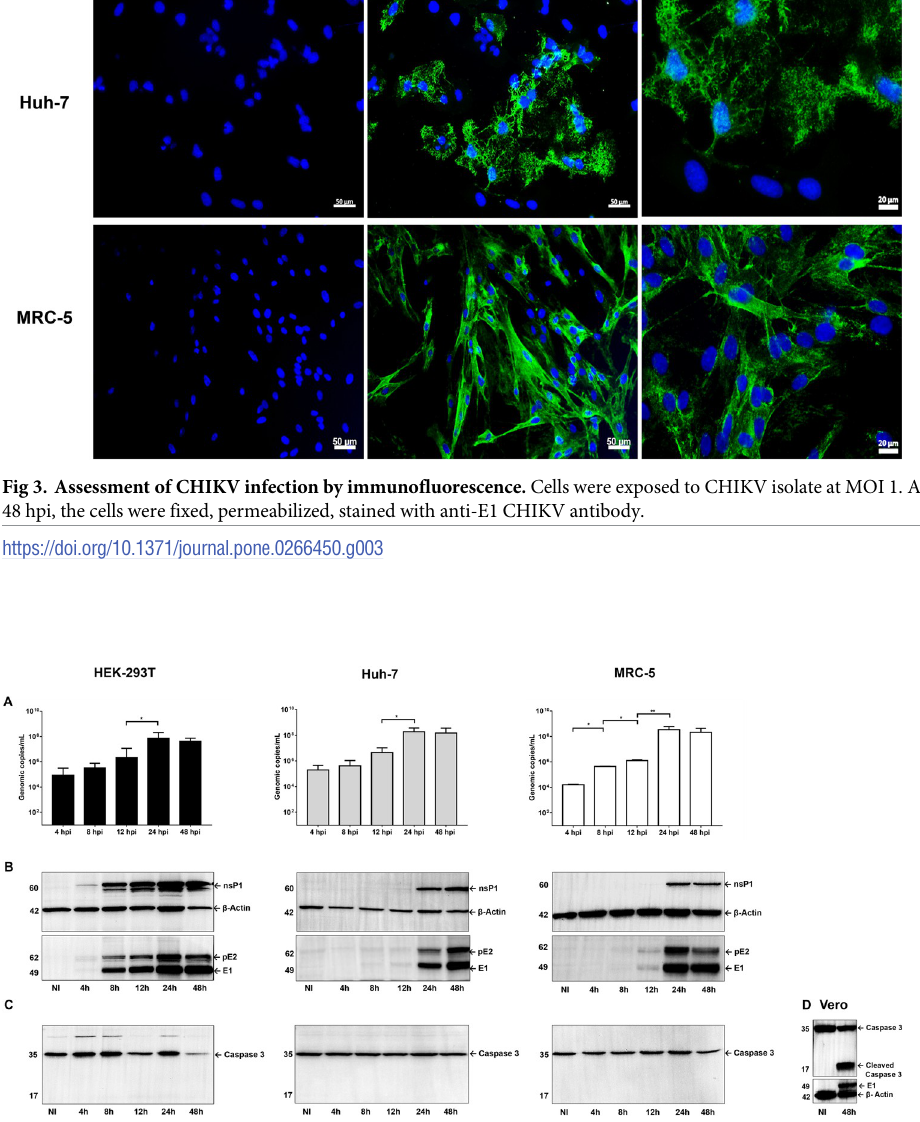
Fig 4. Kinetic analysis of the COL7624 isolate. Cells were infected at MOI 1 and harvested at the specified time points. Supernatants were collected, and the gRNA content was quantified by RT-qPCR assay based on E1 amplification (A). The cells were lysed and analyzed by western blotting using antibodies against nsP1 and E1/E2 proteins (B) and anti-caspase 3 (C, D). β - actin was used as a loading control. Statistical comparisons were performed using non-parametric Mann–Whitney tests ( � P < 0.05; �� P < 0.01; and ��� P < 0.001).